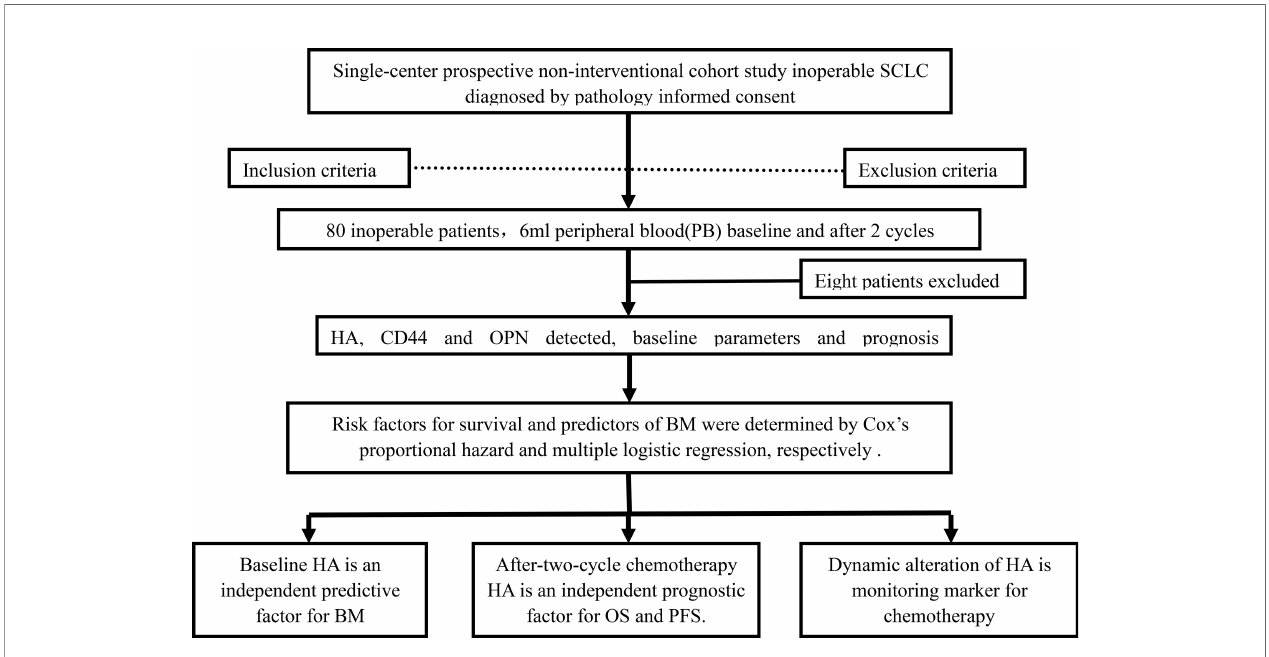
FIGURE 1 | Flowchart of the study design and patient